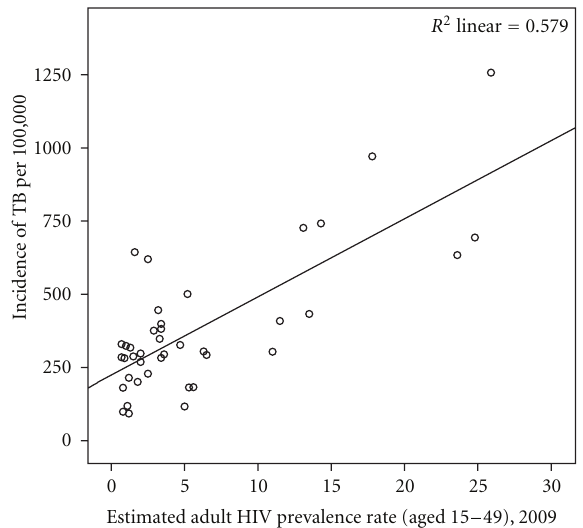
Figure 1: The association between HIV prevalence and TB in sub- Saharan